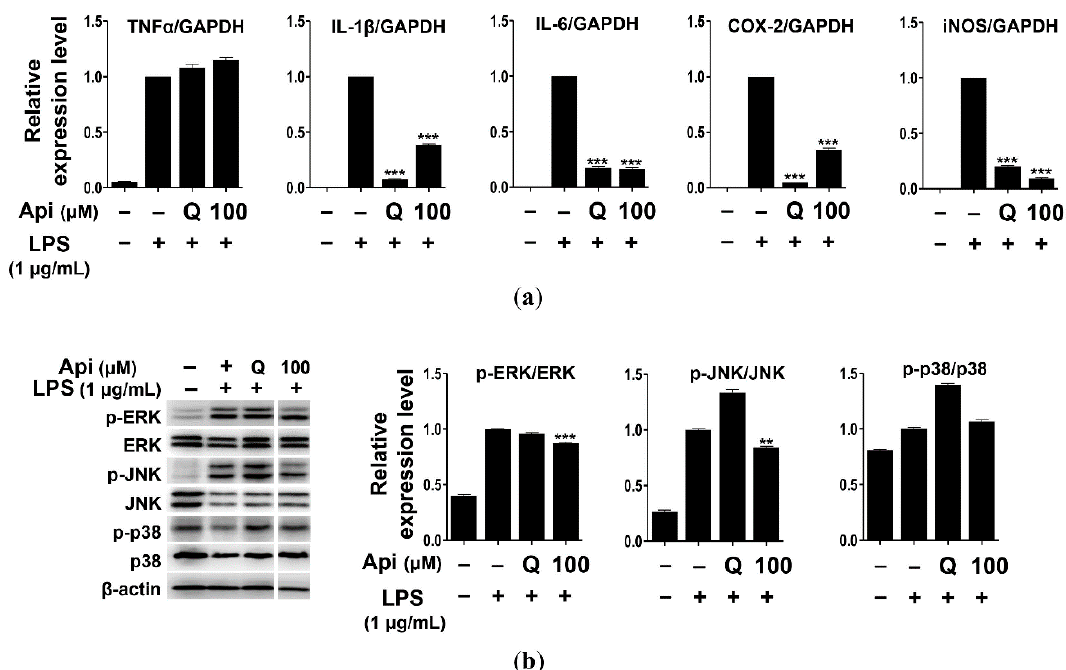
Figure 3. Effects of apigenin on the expression of cytokines ( a ) and mitogen-activated protein kinase (MAPK) signaling molecules ( b ) in RAW264.7 cells. Cells were treated with apigenin (100 µ M) for 24 h. Api, apigenin; LPS, lipopolysaccharide; Q, quercetin (15 µ M). The data were analyzed using one-way analysis of variance (ANOVA) followed by Tukey’s test. ** p < 0.01, *** p < 0.001 versus LPS-induced cells without apigenin treatment.